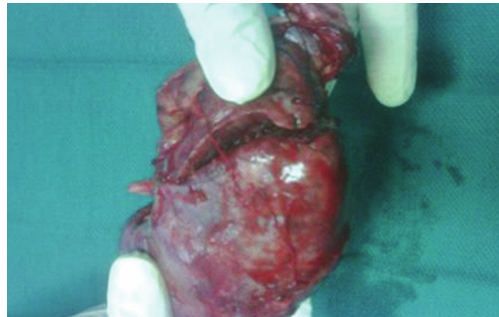
Figure 2: Oblique laceration on in the upper pole and mid portion of the kidney compatible with ruptured graft.